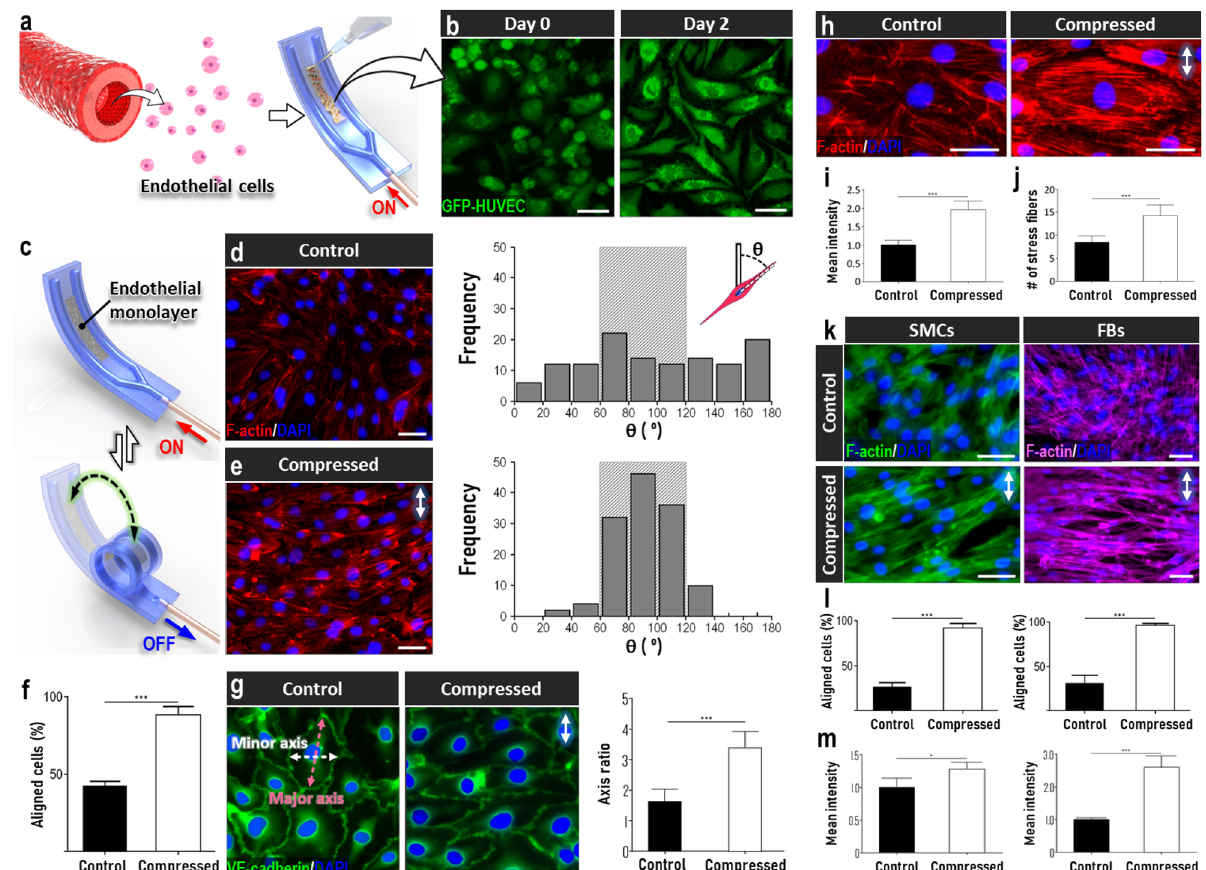
Figure 3. Responses of mechanosensitive cells to dynamic compression. ( a,b ) Monolayer culture of green fluorescence protein (GFP)-expressing HUVECs in the uncoiled device. Scale bar, 50 µm. ( c ) Cyclic pneumatic actuation of the endothelium-containing device. ( d–f ) Alignment of compressed endothelial cells due to applied compressive force as quantitatively assessed by the distribution of orientation angle ( d,e ) and the percentage of aligned cells ( f ). Scale bars, 50 µm. Any given cell was evaluated to be aligned when its orientation angle defined by the angle between its major axis and the vertical axis was between 60° and 120° (represented by the shaded boxes on the plots). ( g ) Compression-induced cell elongation quantified by the ratio of major to minor axes of cell body. Scale bars, 50 µm. ( h ) Fluorescence visualization of altered intracellular architecture of HUVECs due to compression. The architectural changes were quantified by the mean fluorescence intensity of F-actin staining ( i ) and the number of stress fibers ( j ). Scale bars, 50 µm. ( k ) Mechanosensitive responses of primary human smooth muscle cells (SMCs) and lung fibroblasts (FBs) as evidenced by their reorientation in the perpendicular direction to applied compressive force. Scale bar, 50 µm. ( l,m ) Quantification of cell alignment ( l ) and F-actin fluorescence intensity ( m ). Arrows in this figure show the direction of applied cyclic compression. ***P < 0.001, **P < 0.01, *P < 0.05. Data show mean ± SD with n =